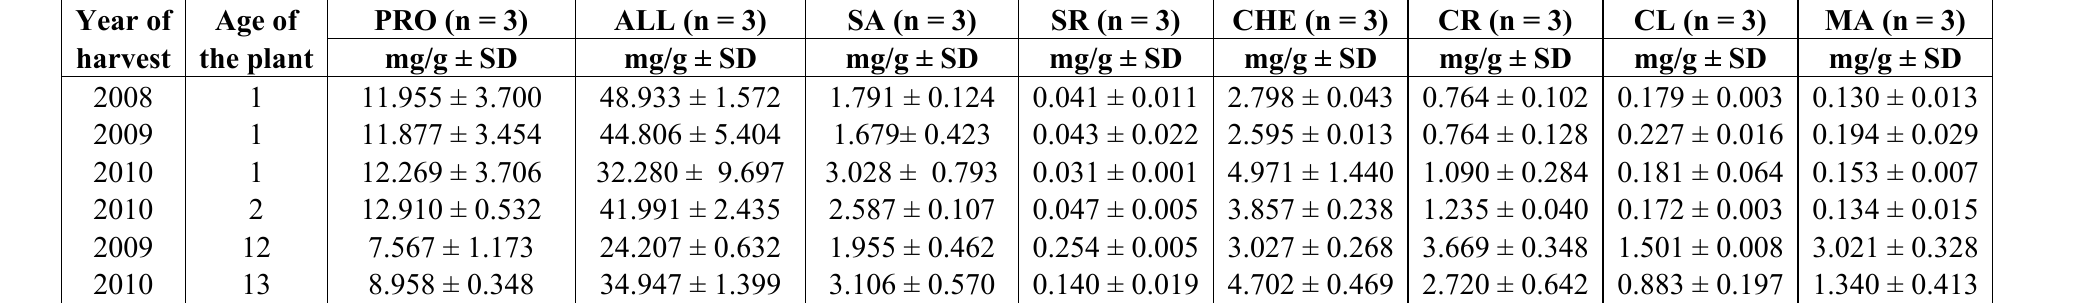
Table 3. Content of isoquinoline alkaloids from underground part of M. microcarpa depending on the age of herb.